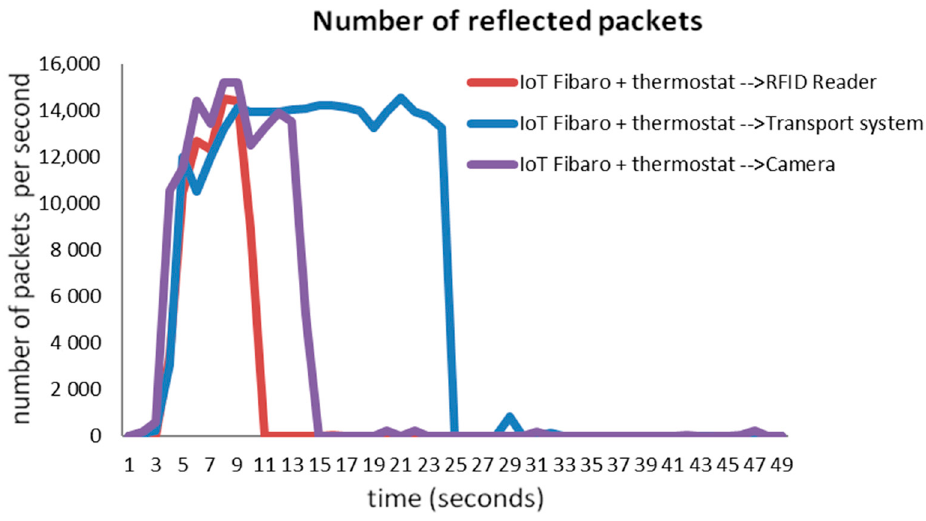
Figure 6. A visual illustration of the scenario 2 attack.